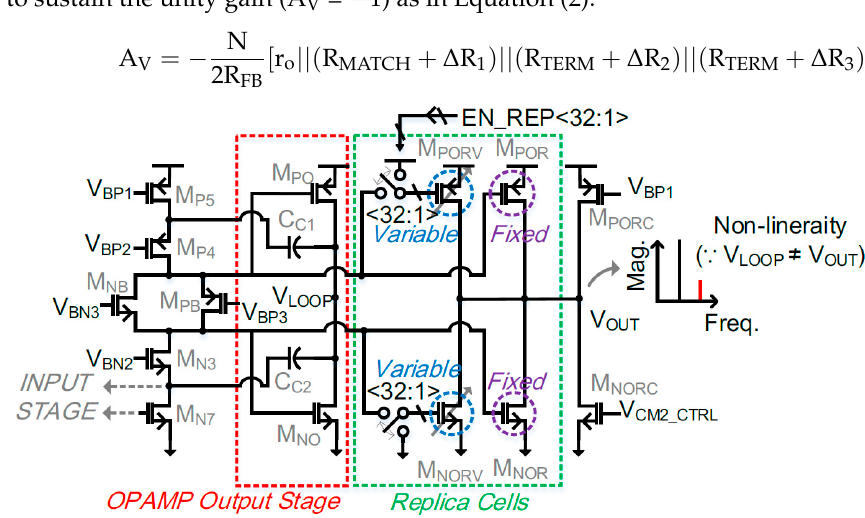
Figure 7. Schematic of the OPAMP’s output stage and current replica cell.